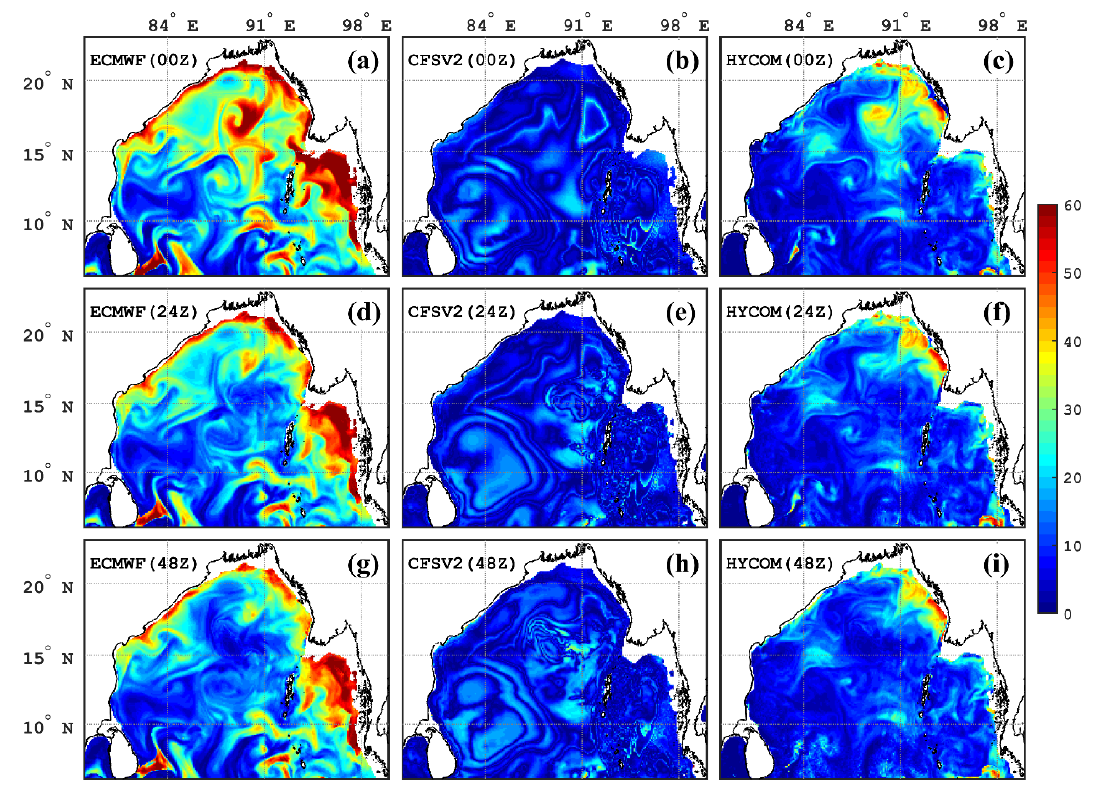
Figure 12. Spatial distribution of barrier layer thickness (BLT) at 00 h ( a – c ), 24 h ( d – f ), and 48 h ( g – i ) for all three experiments.